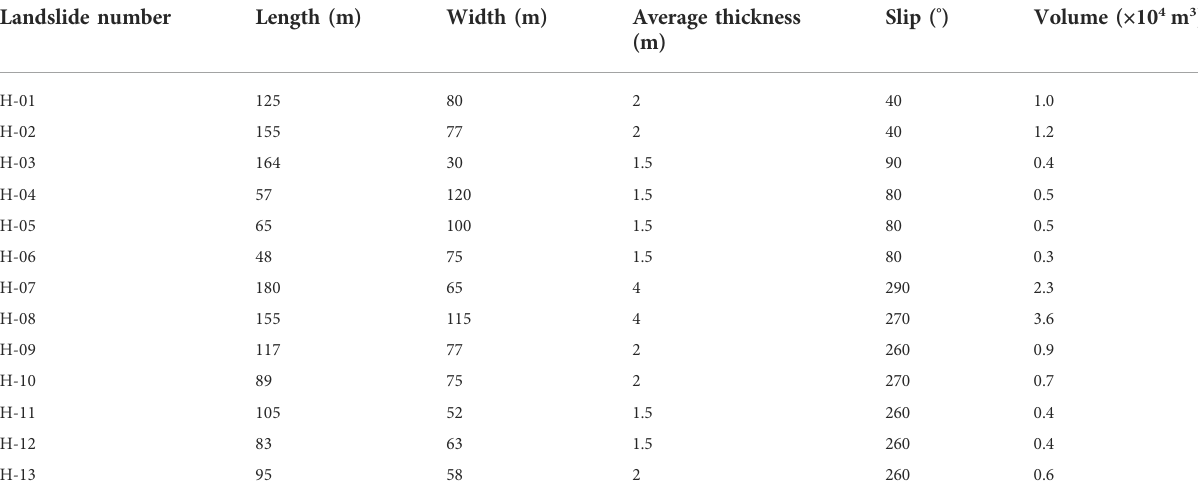
TABLE 2 Statistics of the geometric characteristic parameters of landslides on the Zhangjiayuan gully bank. Landslide